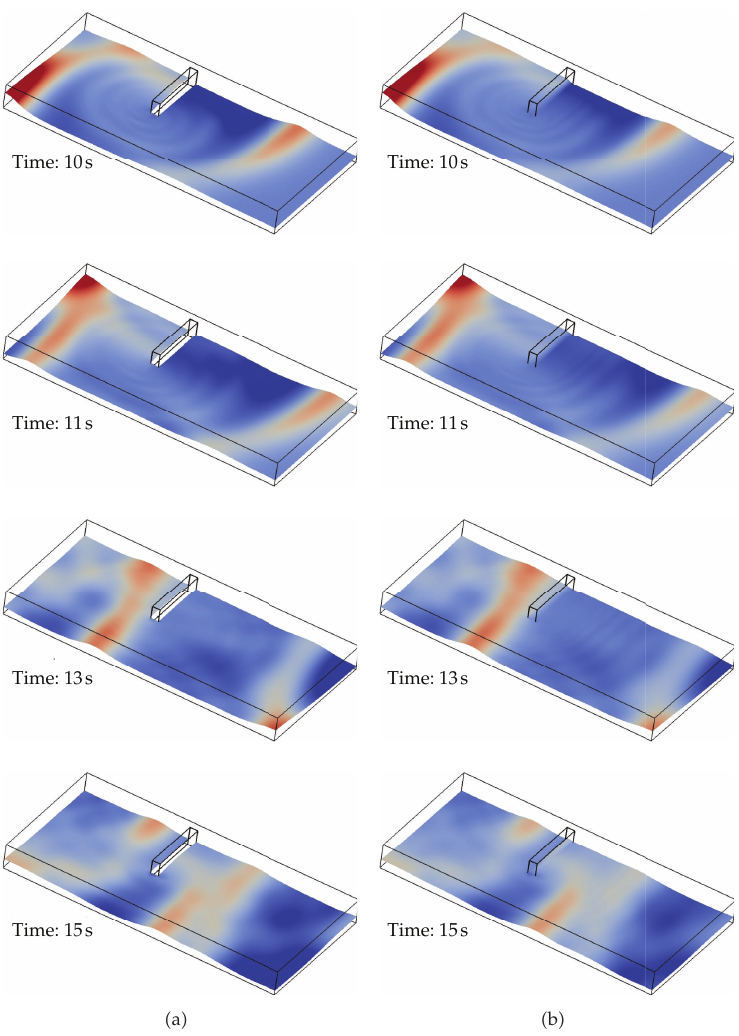
Figure 4: Snapshots at di ff erent times of the solitary wave interacting with the impermeable structure (cid:2) a (cid:3) and the porous one (cid:2) b (cid:3)